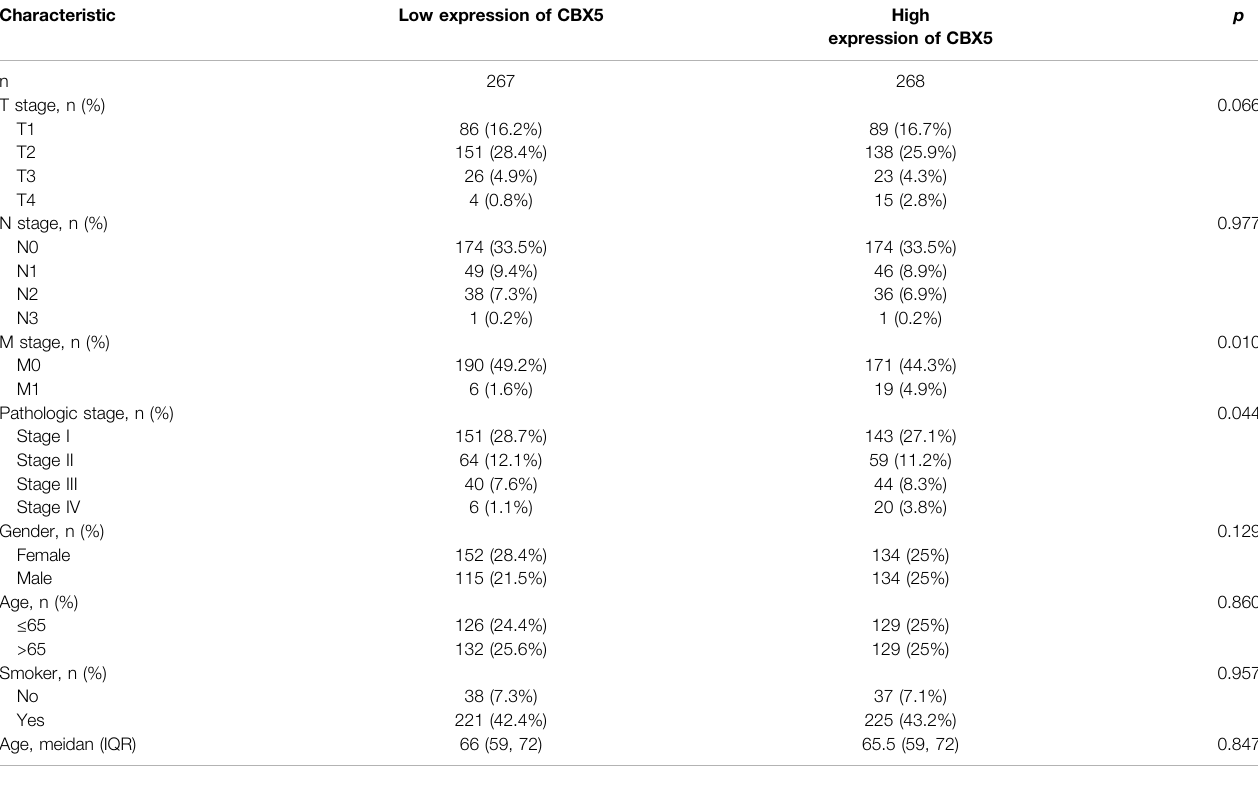
TABLE 3 | Correlation between CBX7 expression and clinicopathologic characteristics of LUAD patients (n (cid:1) 535). Characteristic Low expression of CBX7 High